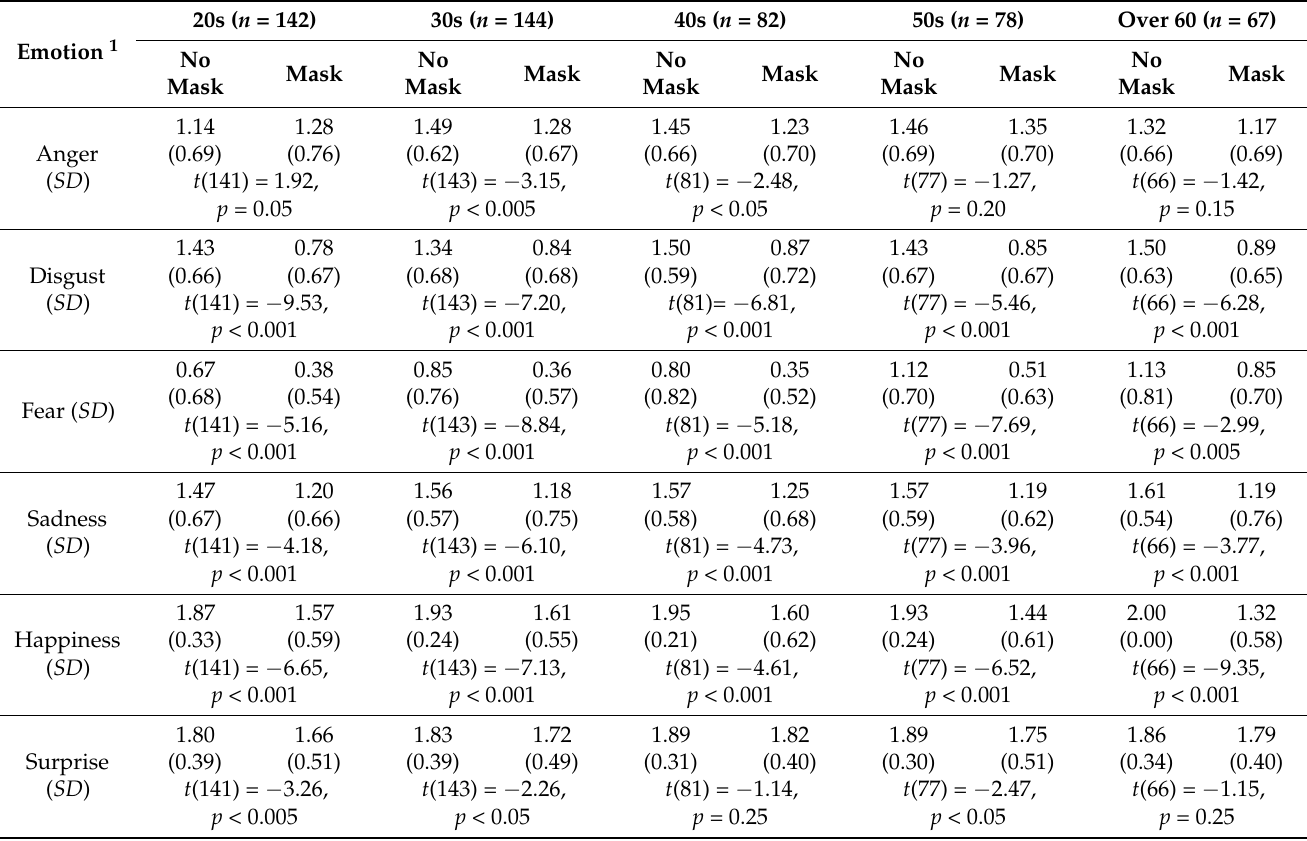
Table 2. Comparisons of participants’ accuracies to recognize senders’ facially expressed emotions between no mask and mask conditions for participant age